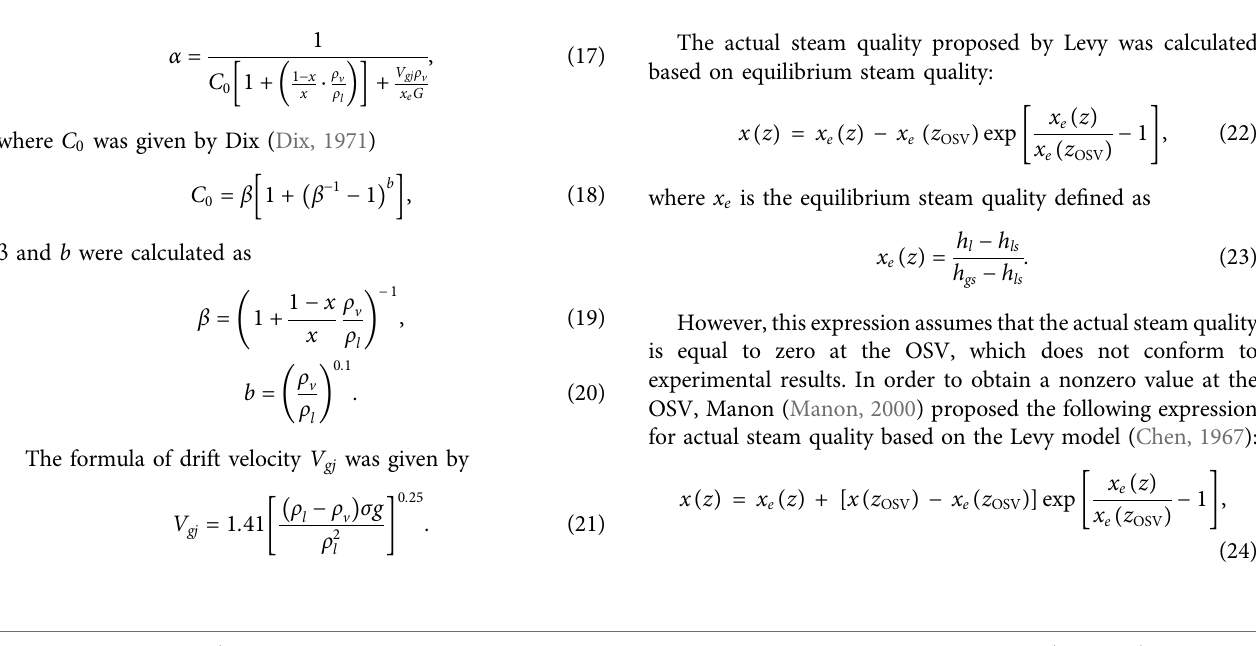
Frontiers in Energy Research |